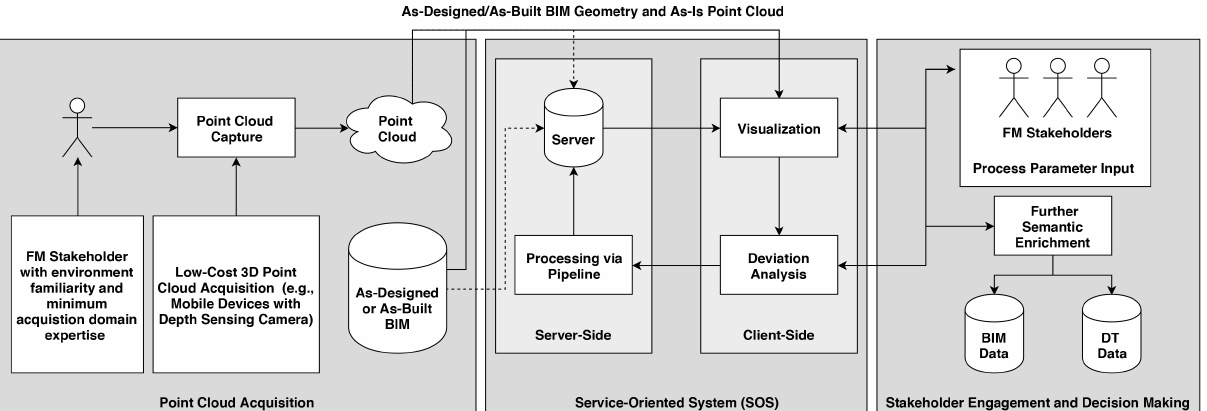
Figure 2. A high-level overview of the associated processes for capture, processing and visualization of indoor point clouds. These processes and components form the main parts of the proposed SOS-based processing pipeline for indoor point clouds representations, and further semantic-enrichment and stakeholder engagement